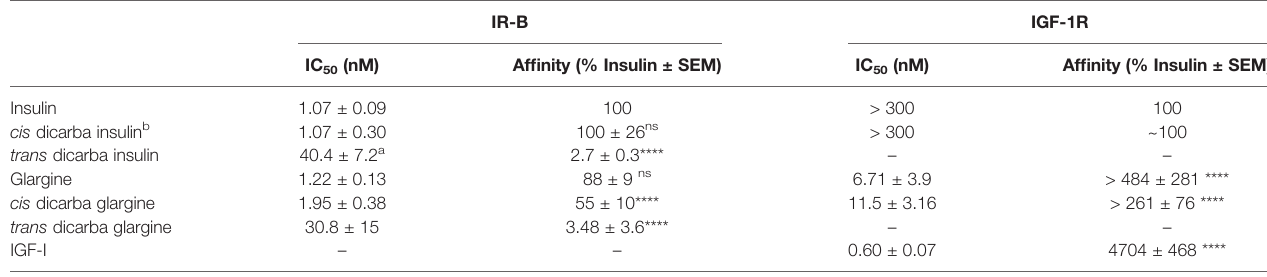
TABLE 1 | Binding af fi nities of IR-B and IGF-1R.